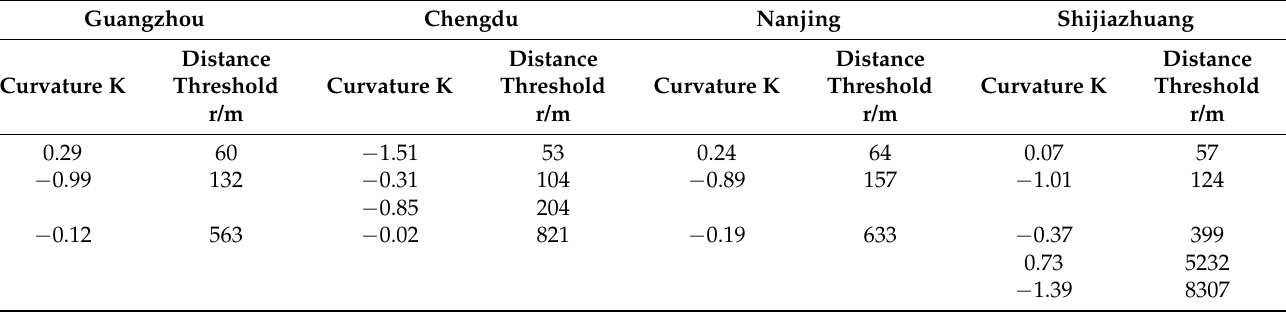
Table 3. Curvature extremum of expansion curve.